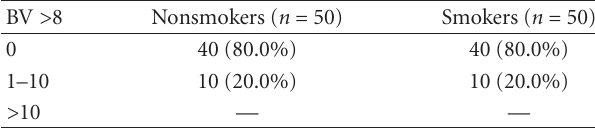
Table 13: Comparison of BV diameter > 8mm between nonsmok- ers and smokers.